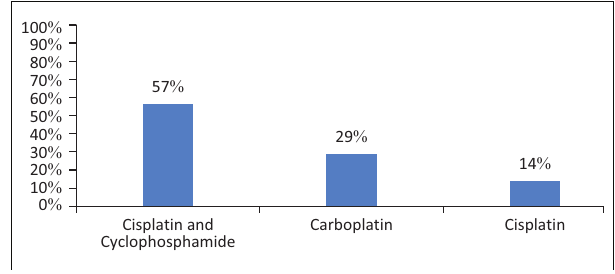
FIGURE 4: Percentage of children receiving various chemotherapeutic regimens ( n = 7).